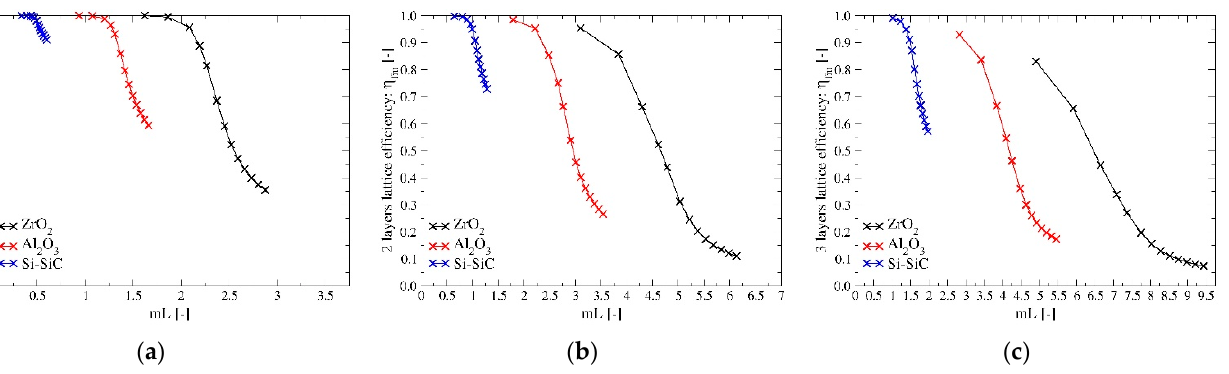
Figure 9. ( a – c ) Lattice efficiency of the three geometries for the three materials investigated in this work as a function of the non-dimensional parameter “mL” defined in Equation (5).